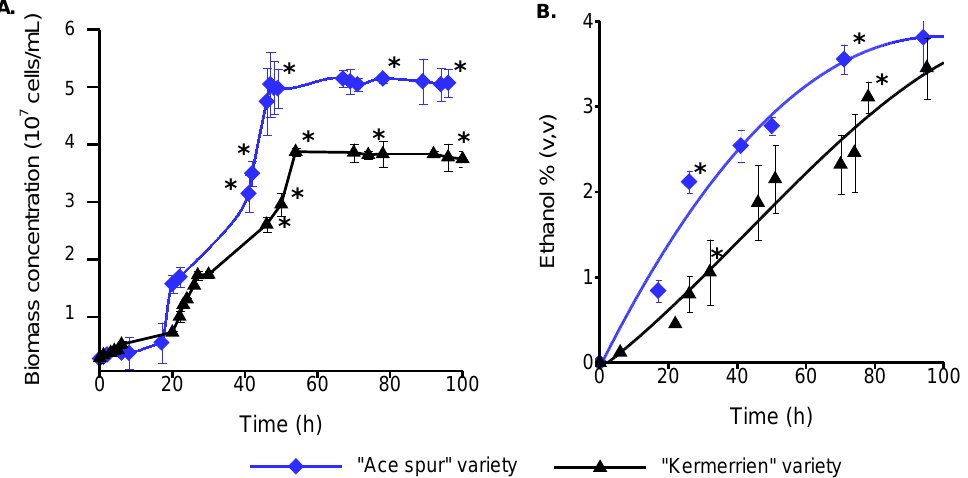
Figure 4. Kinetics of growth ( A ) and ethanol production ( B ) of Hanseniaspora sp. fermentation in “Ace Spur” and “Kermerrien” apple juices. Continuous lines are provided to guide the eye. “*” denotes significant differences.